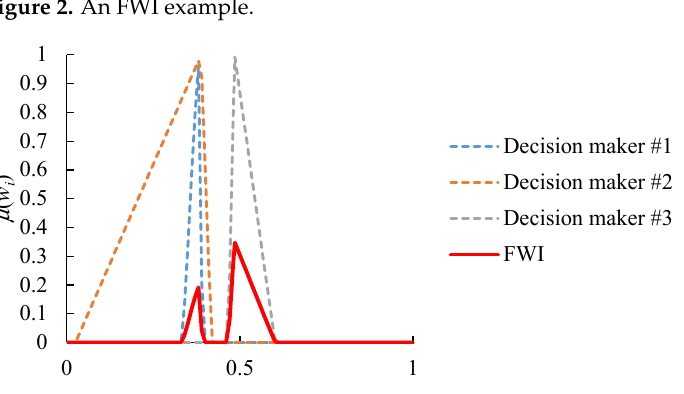
Figure 2. An FWI example.